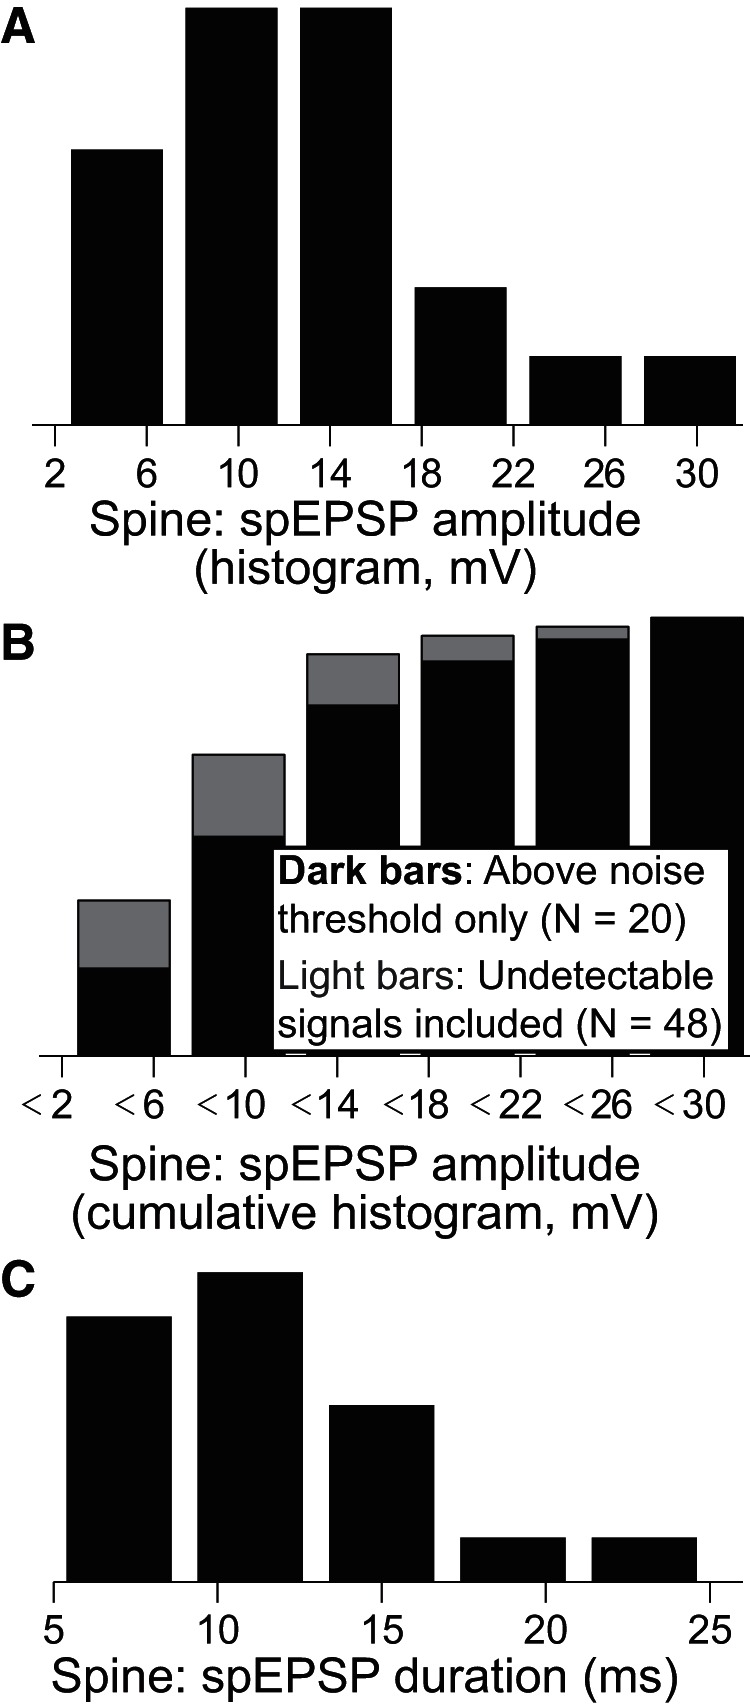
Amplitude and duration of uncaging-evoked spEPSPs. A, Histogram of calibrated spEPSP amplitudes, produced from a dual-exponential fit, and taken only if fit amplitude exceeded noise levels (σnoise) by a factor of at least 2.5 (mean = 13.0 ± 6.7 mV, N = 20, calibrated using optical bAP measurements as shown in Fig. 2). B, Cumulative histograms of spEPSP amplitudes. Dark bars correspond to supra-noise threshold data from A. Additionally, noise thresholds from experiments with no measurable spEPSP (N = 28, but each still shows clear optical bAP from the spine and somatic EPSP as in Fig. 3) can be included because actual amplitudes must be less than this number (mean = 10.1 ± 5.6 mV, N = 48 total; light behind dark bars). C, Histogram of the uncaging-evoked spEPSP half-widths (taken from fit curves, N = 19 spines, 1 point at 45 ms omitted; mean = 11.7 ms).